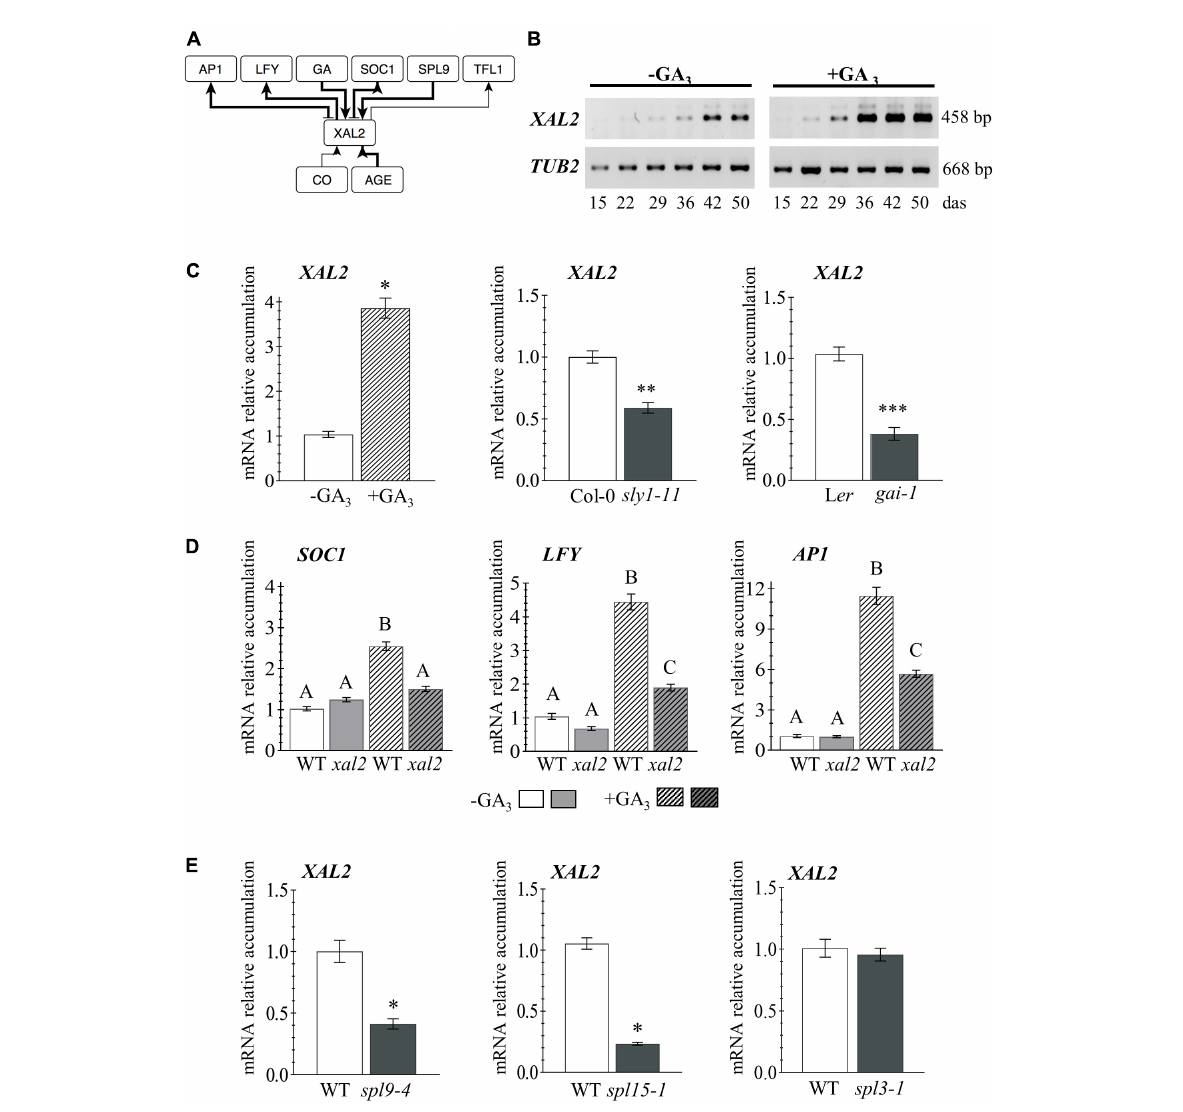
FIGURE1 XAL2 regulation. (A) Scheme of XAL2 regulatory interactions with components of the floral transition GRN under LD and SD conditions. (B) XAL2 mRNA accumulation kinetics in aerial tissues during development and in response to GA 3 addition. (C) XAL2 is induced by GA 3 in plants of 26 days after sowing (das) and it is downregulated in two GA signaling mutants at 45 das when endogenous GA levels increase (Eriksson et al., 2006). (D) Accumulation of SOC1 (26 das plants), LFY, and AP1 (36 das plants) mRNA in response to GA 3 is partially compromised in the xal2 mutant. (E) XAL2 is positively regulated by SPL9 and SPL15, but not by SPL3 under the same SD conditions (36 das plants). (B–E) Plants were grown in SD. For (C–E) , RNA was extracted from shoot apices. Data represent the mean value ± standard error. Statistically significant differences in (C,E) were confirmed with Student’s T -Test ( ∗ P < 0.05; ∗∗ P < 0.01; ∗∗∗ P < 0.001), and by One-Way ANOVA ( p < 0.01), followed by a Holm-Sidak’s Multiple Comparison Test denoted by capital letters in (D) (3–4 biological replicates with eight plants